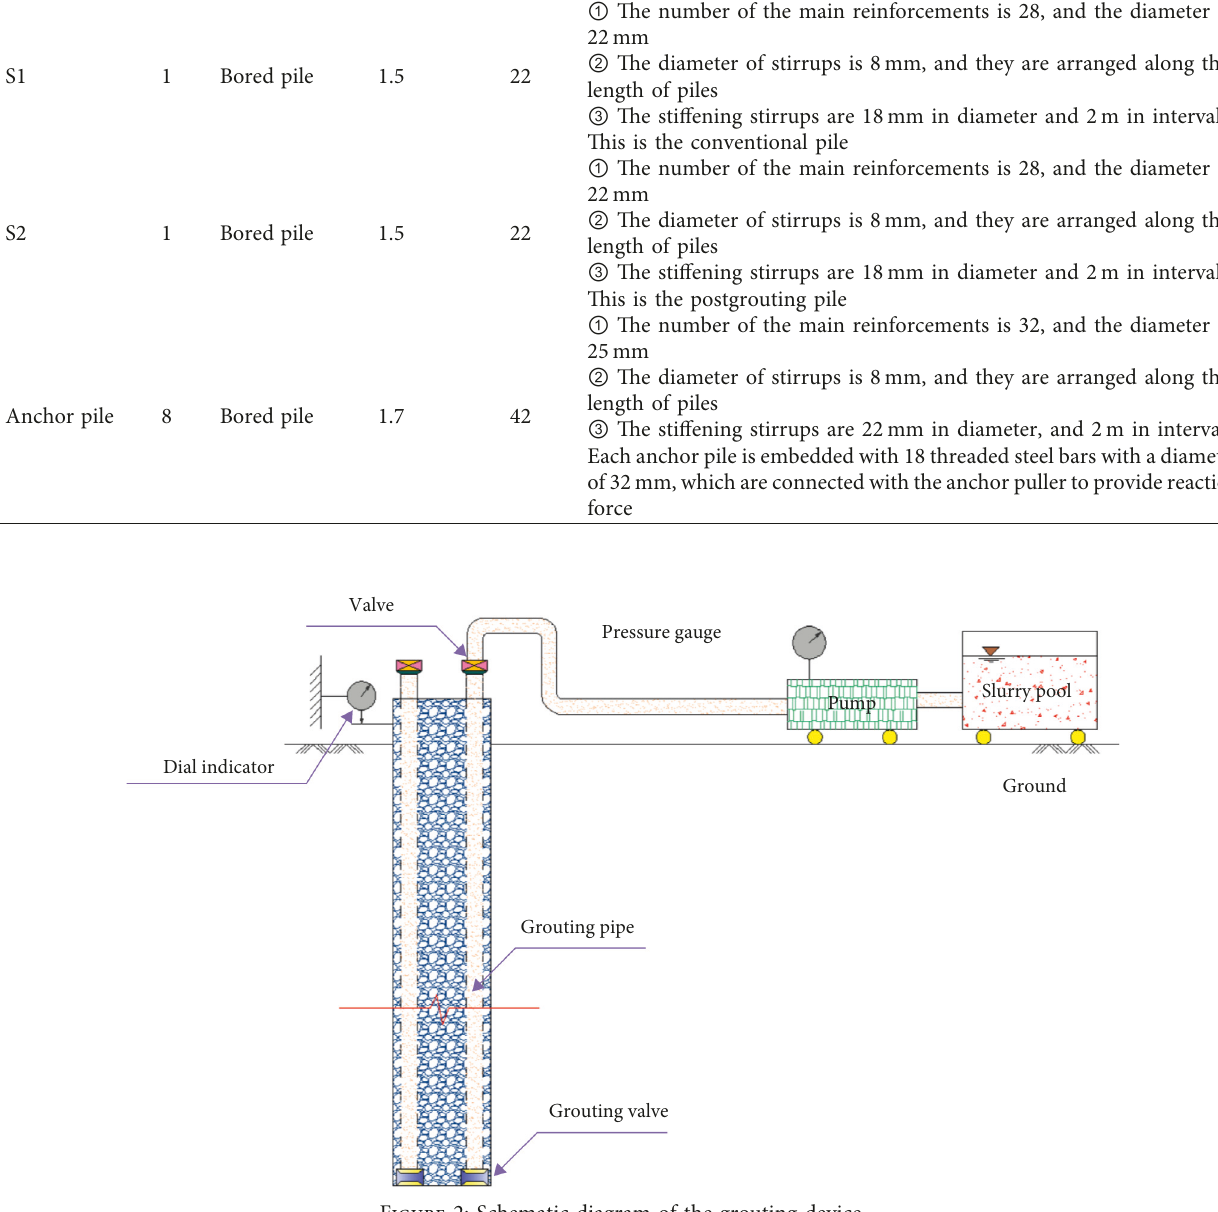
Figure 2: Schematic diagram of the grouting device.